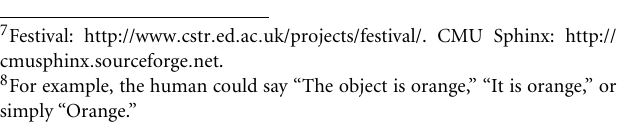
FIGURE 4 | Sketch of the head pose estimation